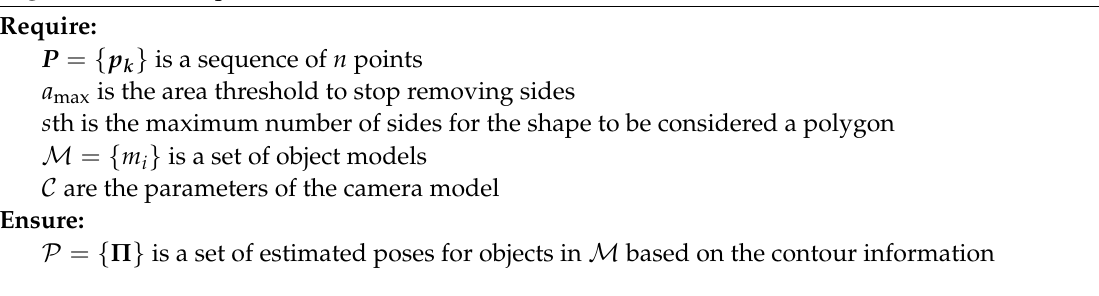
Algorithm 3 Fit